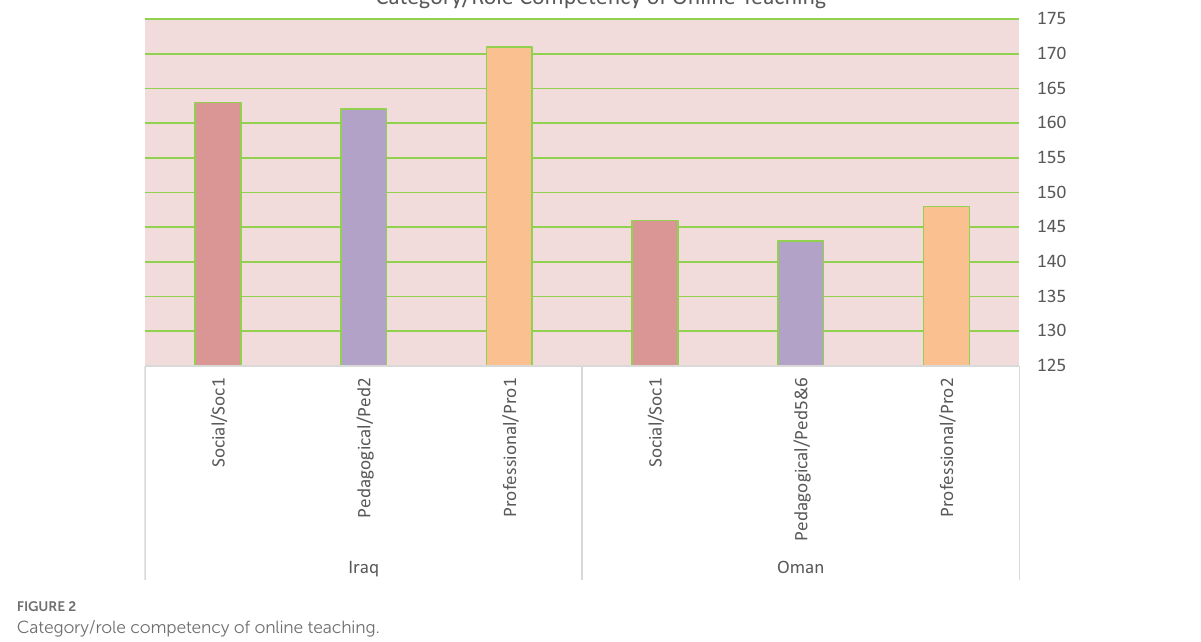
FIGURE 2 Category/role competency of online teaching.